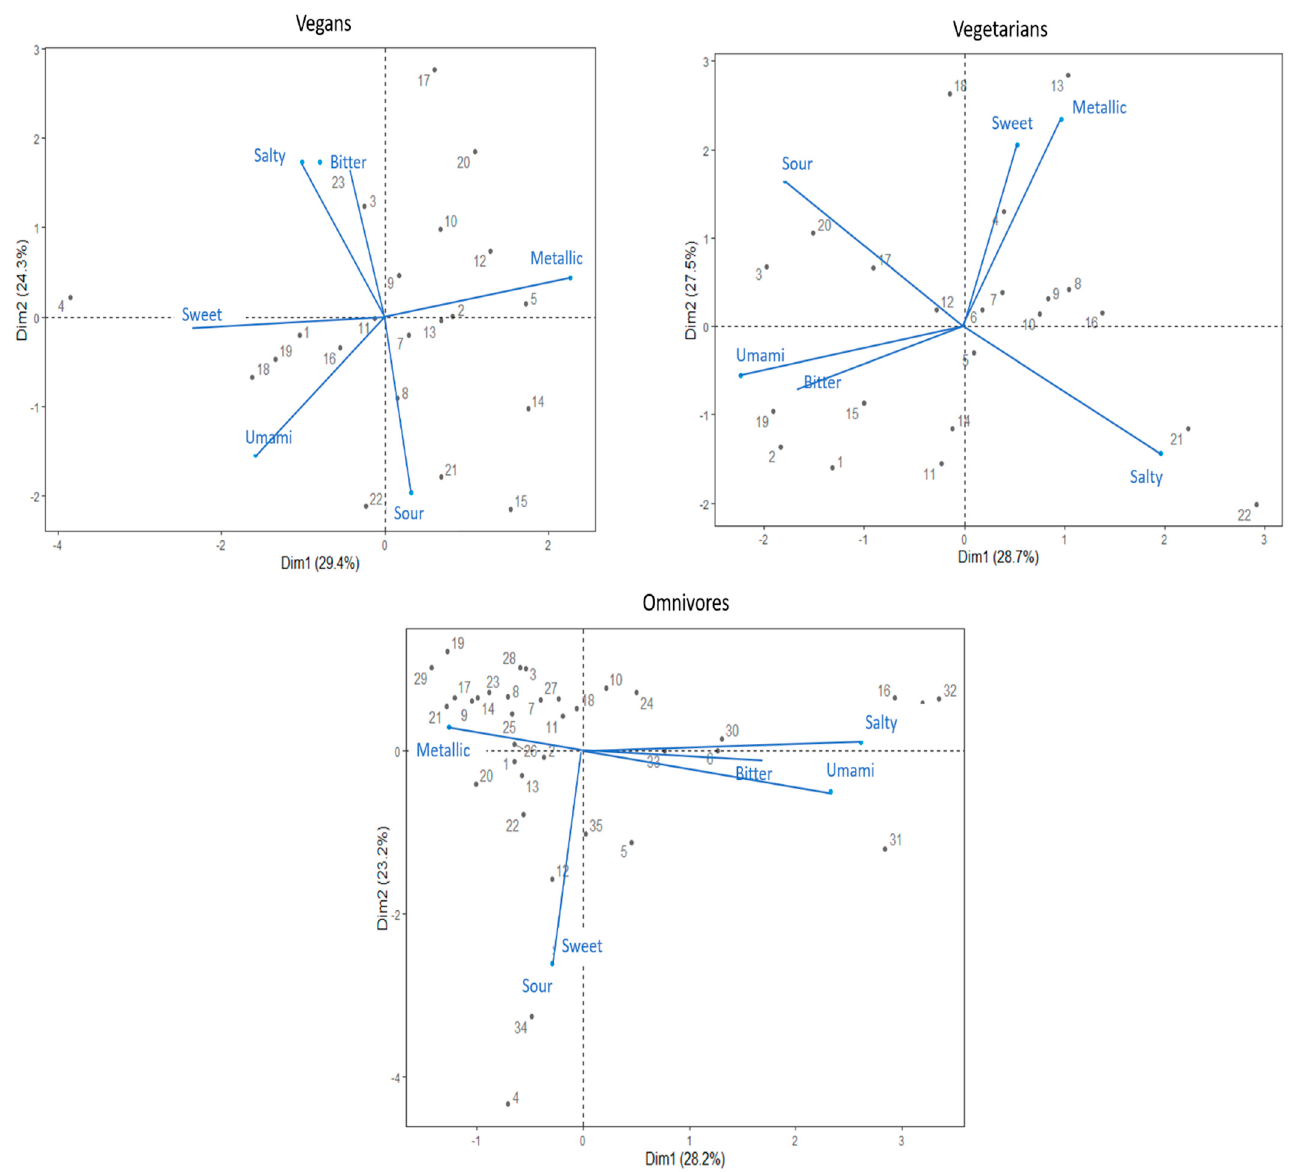
Figure 2. Bi-plots based on principal component analysis based on detection thresholds to six taste compounds. The plots represent data derived from the vegan, vegetarian, and omnivore group, respectively. Numbered points of the PCA represent individual participants by their ID number.